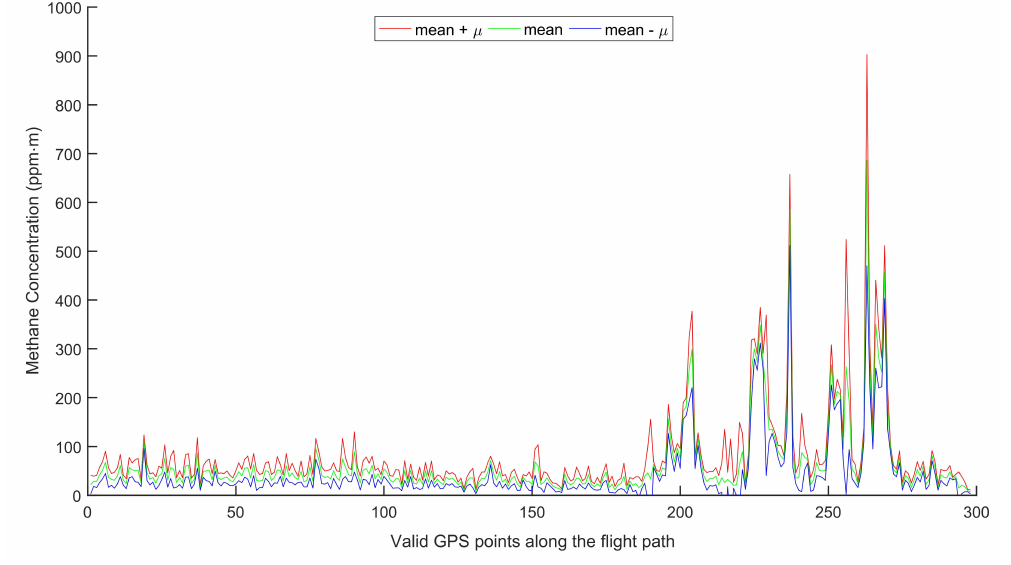
Figure 6. Methane concentration at each GPS location for Flight 1 using a t-distribution with 95% confidence on the values for ± 1 standard